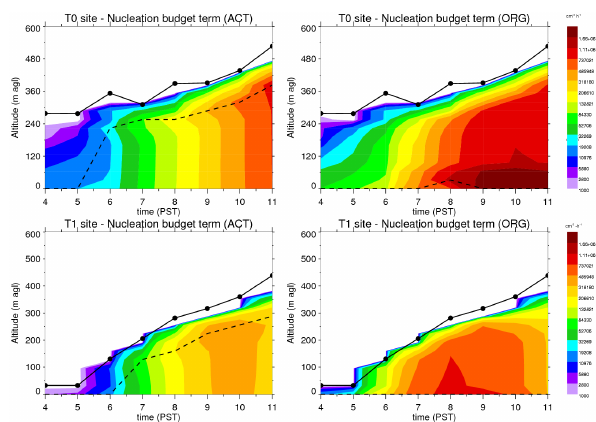
Figure 5. Particle production from the ACT and ORG parameteri- zations at the T0 and T1 sites on 8 June 2010 together with modeled BL height (circled line). The dashed line shows the altitude of the maximum predicted number of small particles.